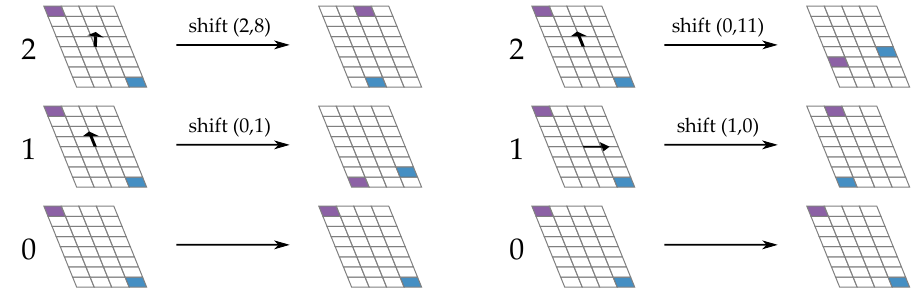
Figure 5: Illustration of ρ east (left) and ρ west (right).